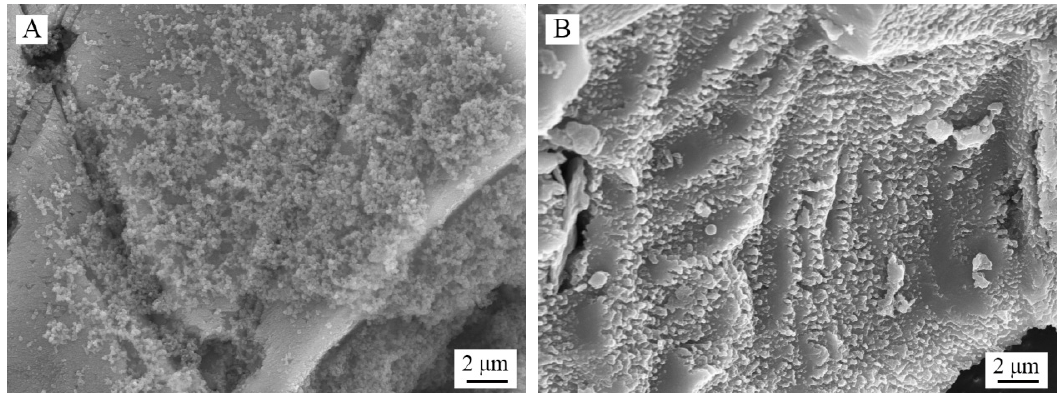
Figure 7. SEM results of chalcopyrite bioleached ( A ) without Triton X-100 and ( B ) with Triton X-100. (Chalcopyrite 1% ( w / v ), Triton X-100 30 mg · L − 1 , initial cell density 2 × 10 7 cells · mL − 1 , initial Fe 2+ 0 g · L − 1 , initial pH 2.0, rotational speed 160 rpm, temperature 30 ◦ C, and leaching for 24